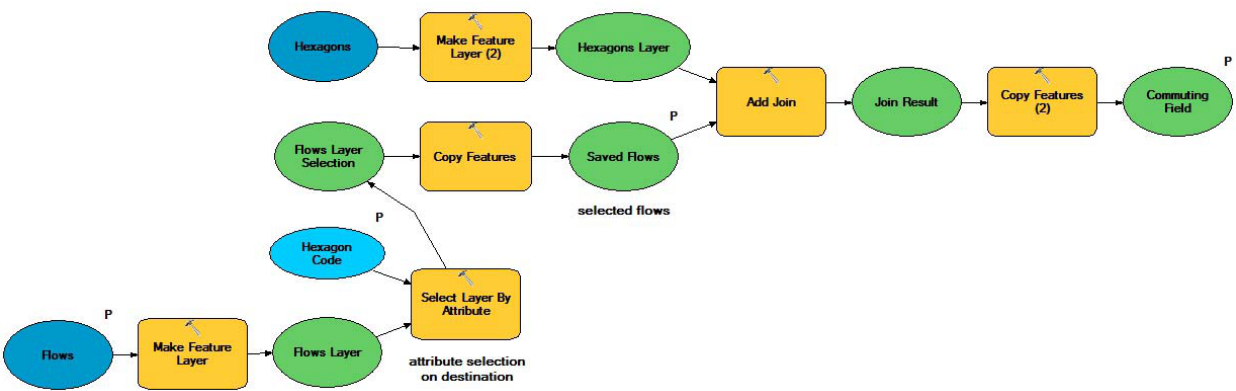
Figure 7. Commuting field builder